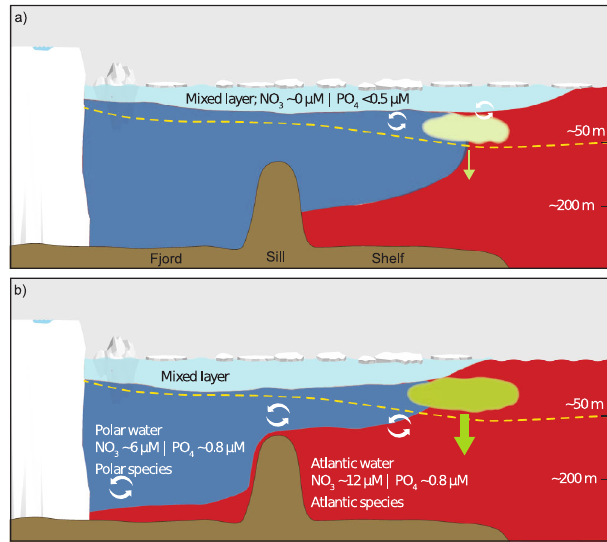
Fig. 6 | Schematic of the changes occurring in summer vertical strati fi cation andpotentialimpactofphytoplanktonproductionontheshelf. Thetransectis aschematicofconditionswithinfjords(left)andeastwardacrosstheshelf(rightof the sill). a Summer conditions where surface waters (light blue) become strati fi ed and are nutrient depleted due to phytoplankton growth and nitrate is the limiting nutrient 1,49 .Nutrientsupplytosurfacewatersisfromentrainmentfromwaterbelow which is either Atlantic Water (AW) or Polar Water (PW) and this supports a sub- surfacephytoplanktoncommunity. The seasonal retreatof sea iceexposes surface waters in the frontal region to greater potential of vertical mixing. b Evolving summer conditions with thinning of the PW layer and further sea-ice retreat, resulting in lower energy required to mix nutrients from AW upwards and deeper penetration of light, and as a consequence potential to sustain higher phyto- plankton productivity and increased export to benthic biota. The yellow dashed line indicates the photic depth, which with a thinning of the PW layer can be expected to deepen and potentially extend further into AW 50